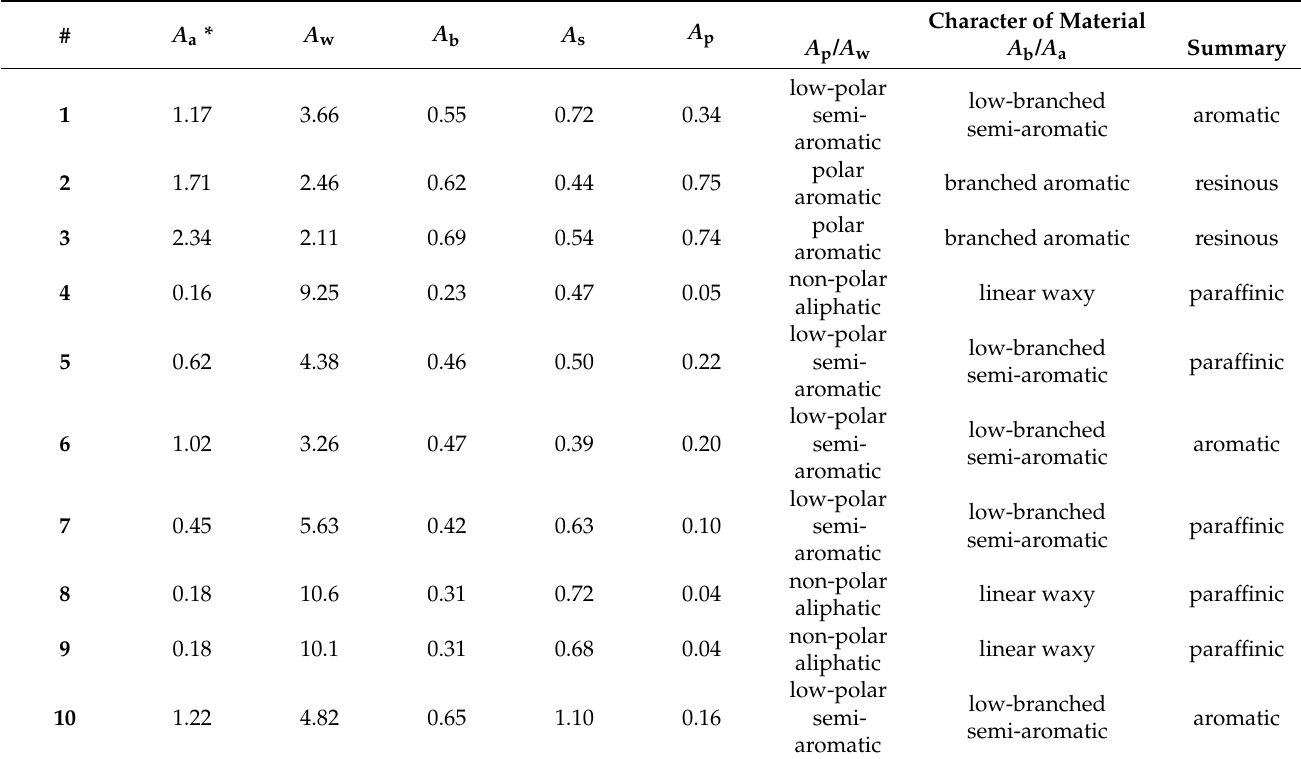
Table 2. Spectral characteristics of bitumens presented in Table